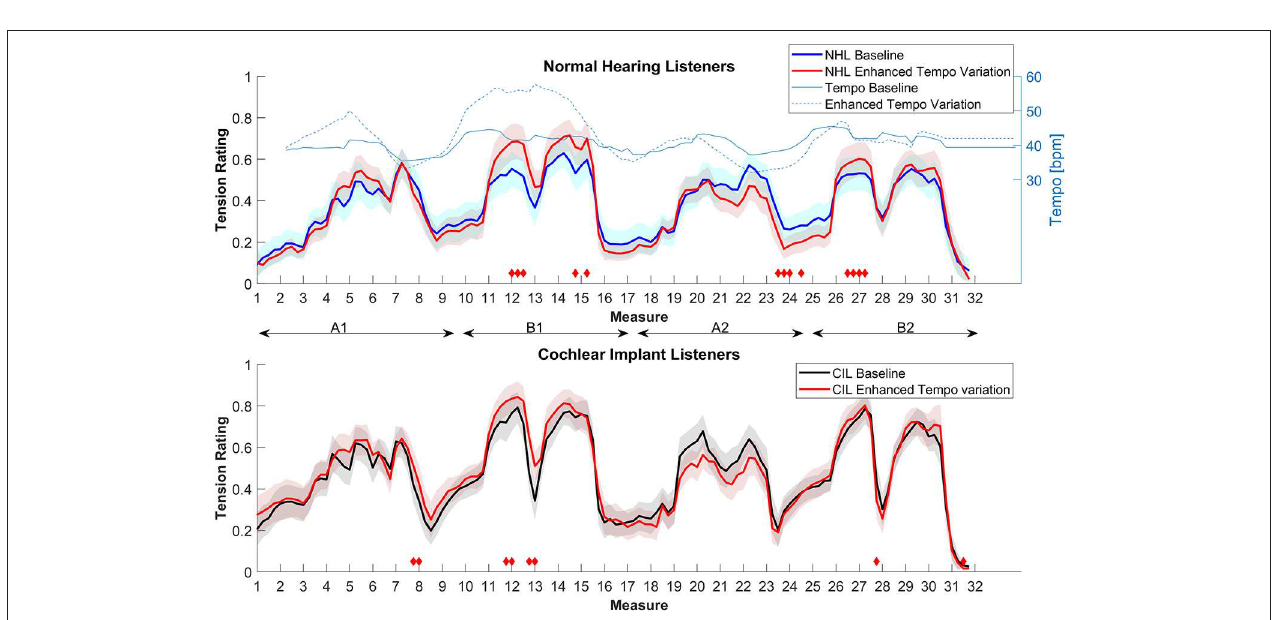
FIGURE 5 | Average tension ratings of 9 NHL (top panel) and 8 CIL (bottom panel) for the baseline and condition 5, enhanced tempo variation (in red). See details in Figure 1 .